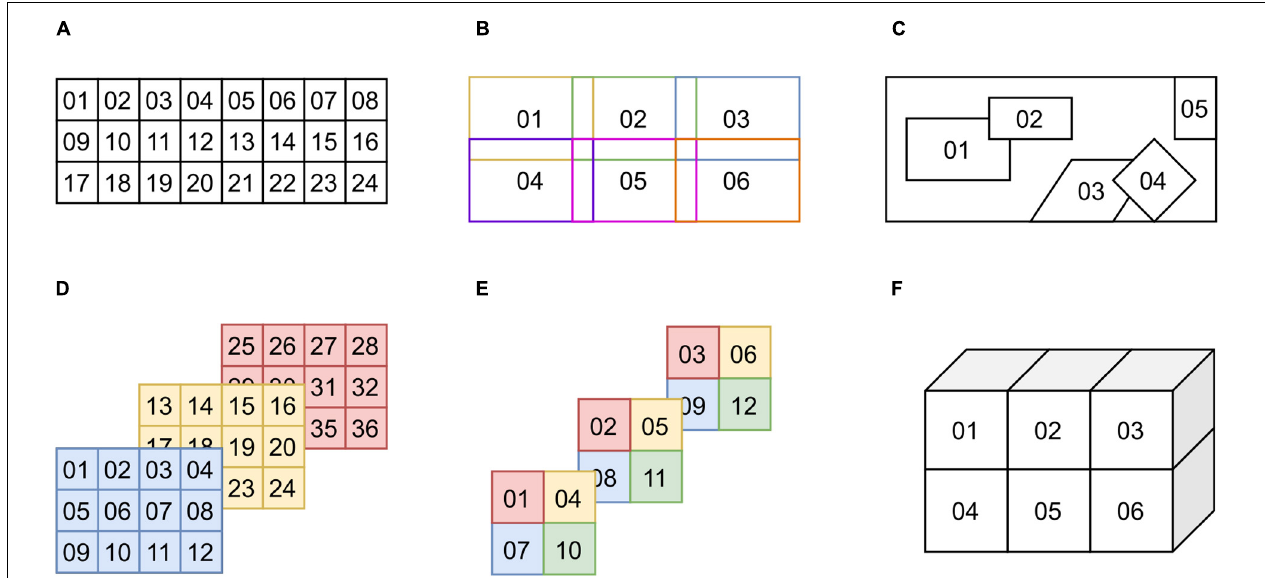
FIGURE 2 | Examples of chunk configurations. (A) Ordered 2D chunks without overlap. (B) Ordered 2D chunks with overlap. (C) Unordered 2D chunks with and without overlap. (D,E) Ordered 2D chunks on different 3D planes. (F) Ordered 3D